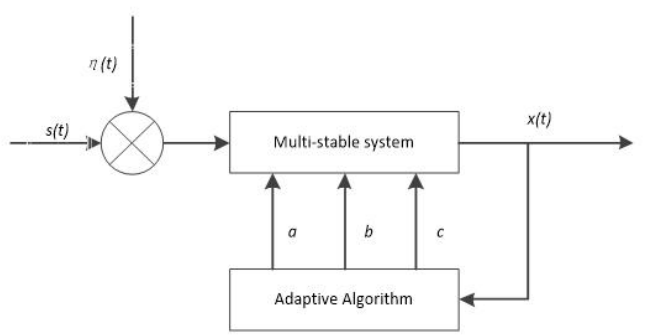
Figure 8. Schematic diagram of an adaptive multi-stationary stochastic resonance